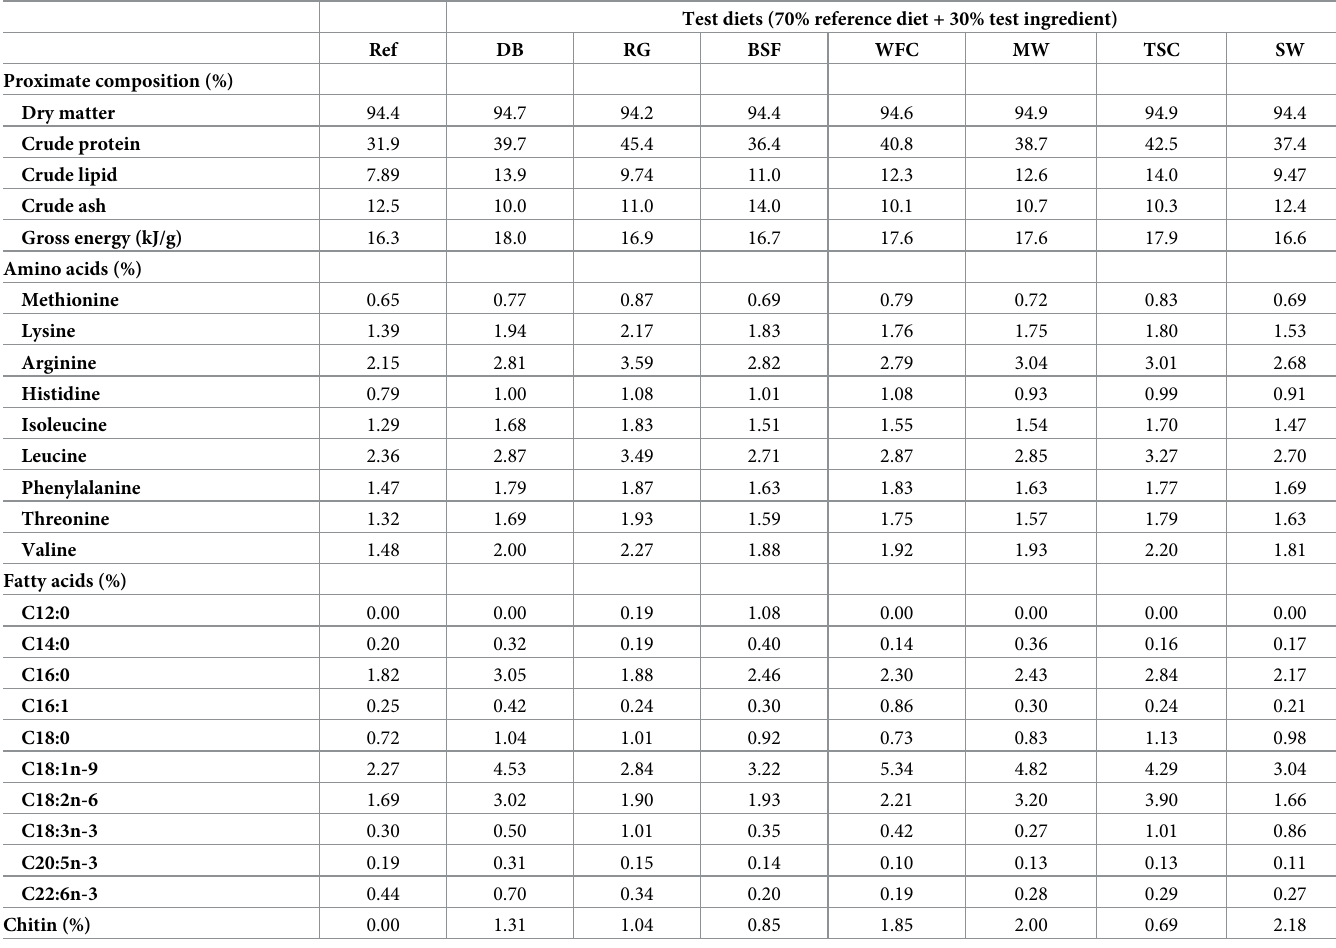
Table 3. Nutrient compositions (%, dry matter) of the reference diet (Ref) and test diets for the digestibility test of Pacific white shrimp ( Litopenaeus vannamei